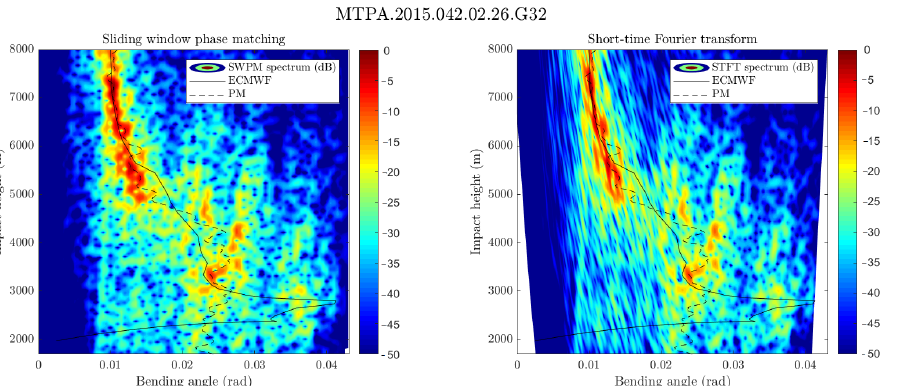
Figure 11. A MetOp-A occultation from UTC 0226 2015-02-10, 21.98 ◦ N, 65.44 ◦ W. Left shows SWPM, right shows STFT. ECMWF BA is shown in solid black, standard PM is shown in dashed black. The window length for STFT is 2.0